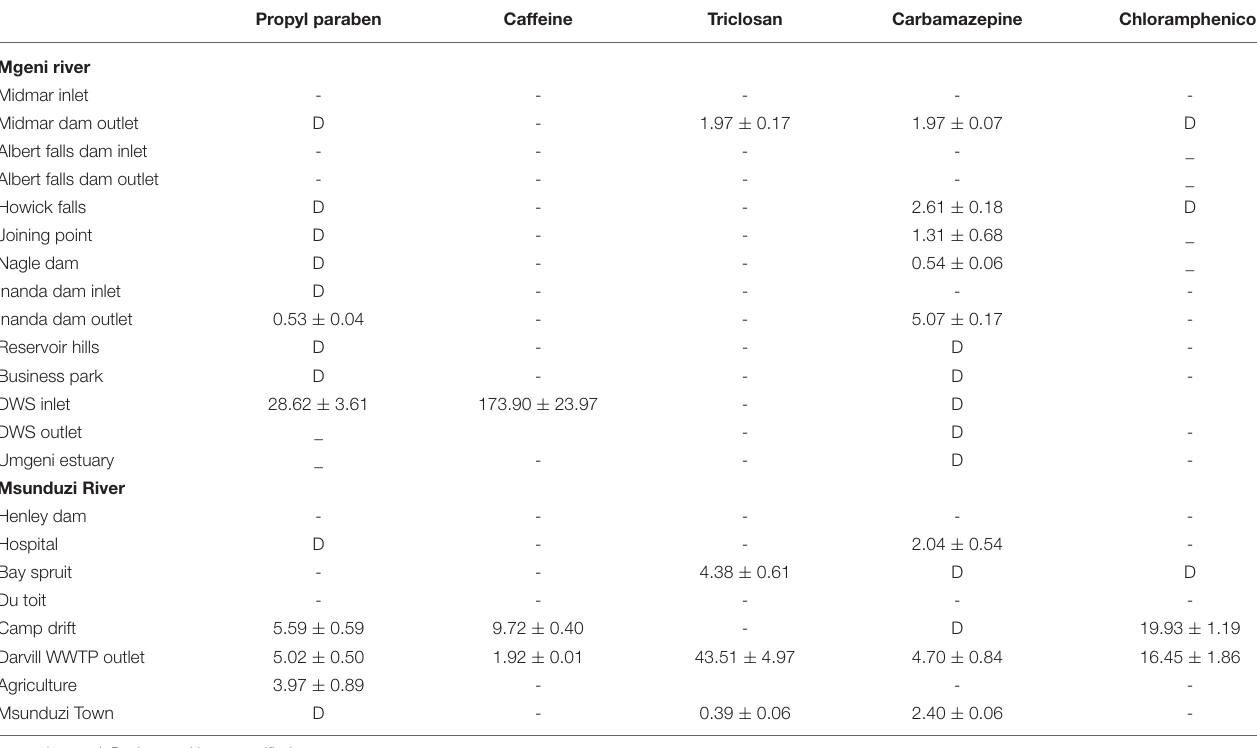
TABLE 4 | Concentration of the studied compounds (ng g-1) in sediments collected in Mgeni and Msunduzi rivers in August.